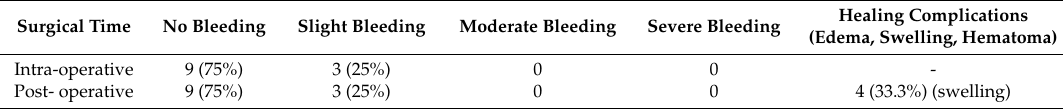
Table 3. Description and incidence of bleeding events on the twelve (12)